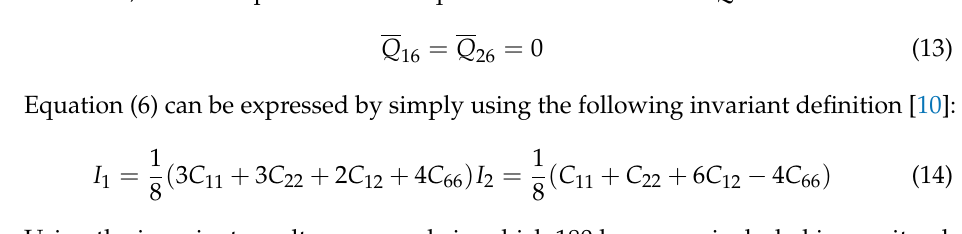
◦ rotation increments of a layer using a raster scanning Figure 3. Schematic of 67° rotation increments of a layer using a raster scanning strategy. Figure 3. Schematic of 67